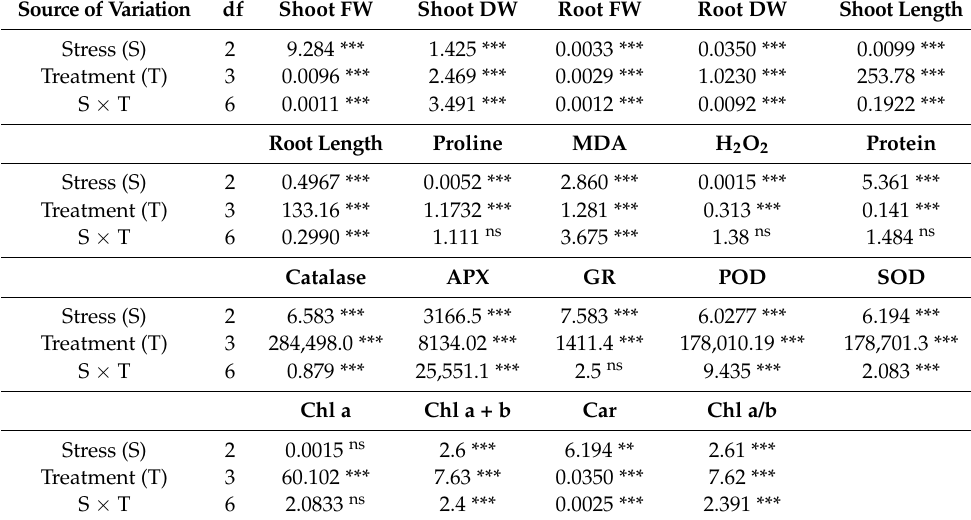
Table 4. Mean Squares from two way analysis of variance data for different morphological and biochemical indicators of Mung bean ( Vigna radiata L.) treated with Bacillus subtilis under chromium